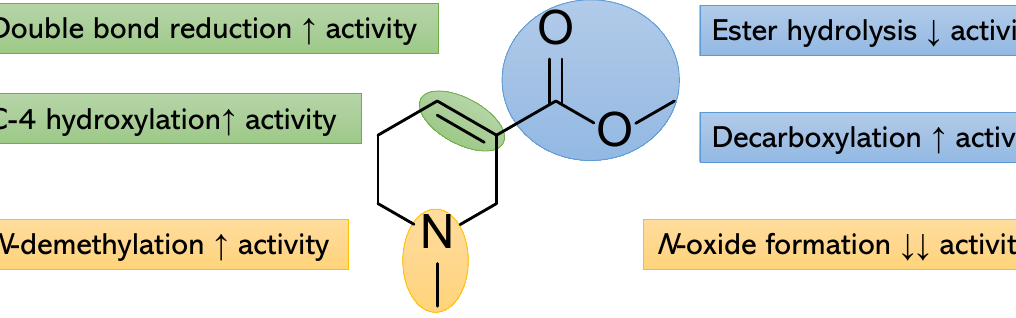
Figure 2. Summary of potential hotspots for structural modification of arecoline metabolites. In Vitro Cytotoxic Activity Using Normal Cell Lines As compounds 1 , 3 , and 5 presented the highest cytotoxic effect amongst the tested compounds, they were further examined against normal lung cell WI38 and normal blood cell PCS-800-016 using MTT assay (Table 2) to determine the selectivity index. The selectivity index identifies the selectivity of the tested compounds toward the cancer cell line and is calculated by dividing the IC 50 against the normal cell line by the IC 50 against the cancer cells. Compounds 1 , 3 , 5 , and staurosporine possessed selectivity indices of 5.93, 3.64, 5.00, and 1.57, respectively, toward non-small-cell lung cancer A549. It was also found that compounds 1 , 3 , 5 , and staurosporine exerted selectivity indices of 6.32, 11.37, 9.35, and 2.56, respectively, toward leukemia cancer cells K562. The value of the selectivity index of compounds 1 , 3 , and 5 indicated high selectivity toward the tested cell lines [32–35], as the higher the magnitude of the selectivity index (more than 3) of a compound is, the greater its selectivity [36]. Table 2. Cytotoxicity and selectivity index (SI) of 1 , 3 , and 5 using normal lung cell WI38 and normal blood cell PCS-800-016 in vitro. Compound Normal Lung Cell Line WI38 IC 50 (µM) ± SD